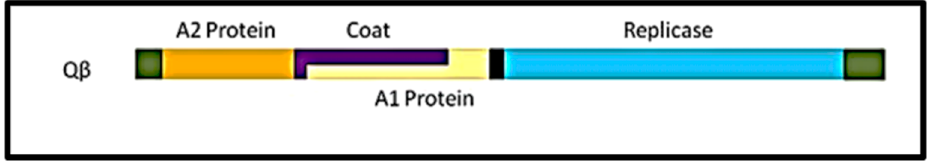
Figure 1. Genome organization of the RNA coliphage Q β . A 2 protein gene or maturation gene (from 62–1321 bases); Cp or major coat protein gene (from 1345–1743 bases); A 1 protein gene or readthrough (from 1345–2331 bases); Replicase or the β -subunit gene of the RNA-dependent-RNA-polymerase (from 2353–4119 bases). The 5 ′ and 3” ends are flanked by non coding bases like any other open reading frame on this genome.